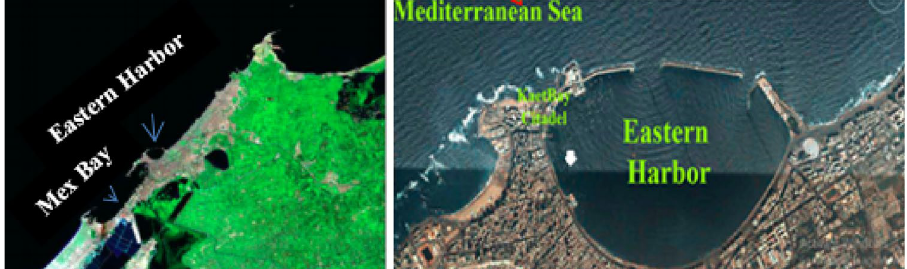
Fig. 1 Satellite image of the Eastern Harbor and location of the sampling